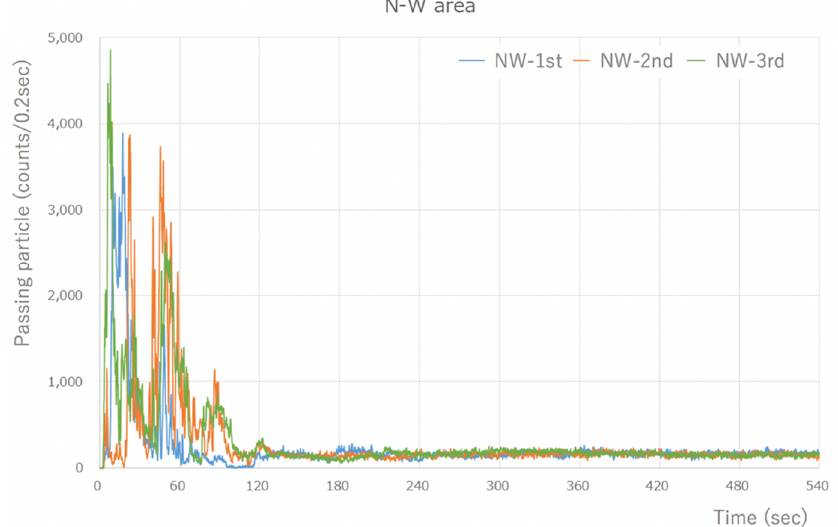
Figure 2. Type-S measurement results (during visualization of the NW area). A large number of particles were detected, at around 4000 counts/0.2 s, immediately after the start. However, the number of particles that were measured after 1 min of work significantly decreased, and a steady state was reached after 60 s. The results are similar for the other areas.